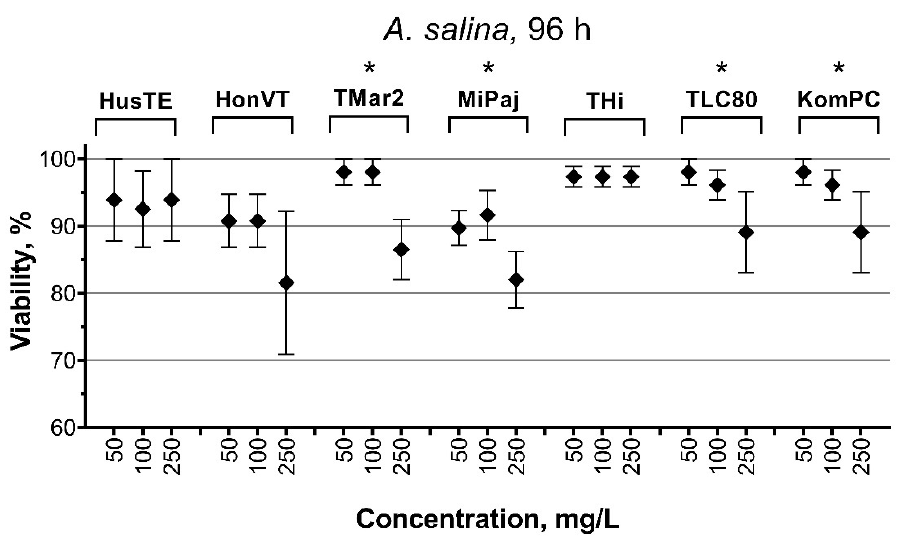
Figure 5. The influence of the VEPs on the viability of A. silina nauplii after 96 h of exposure com- pared with the control (100%). * p < 0.05. (100%). * p <